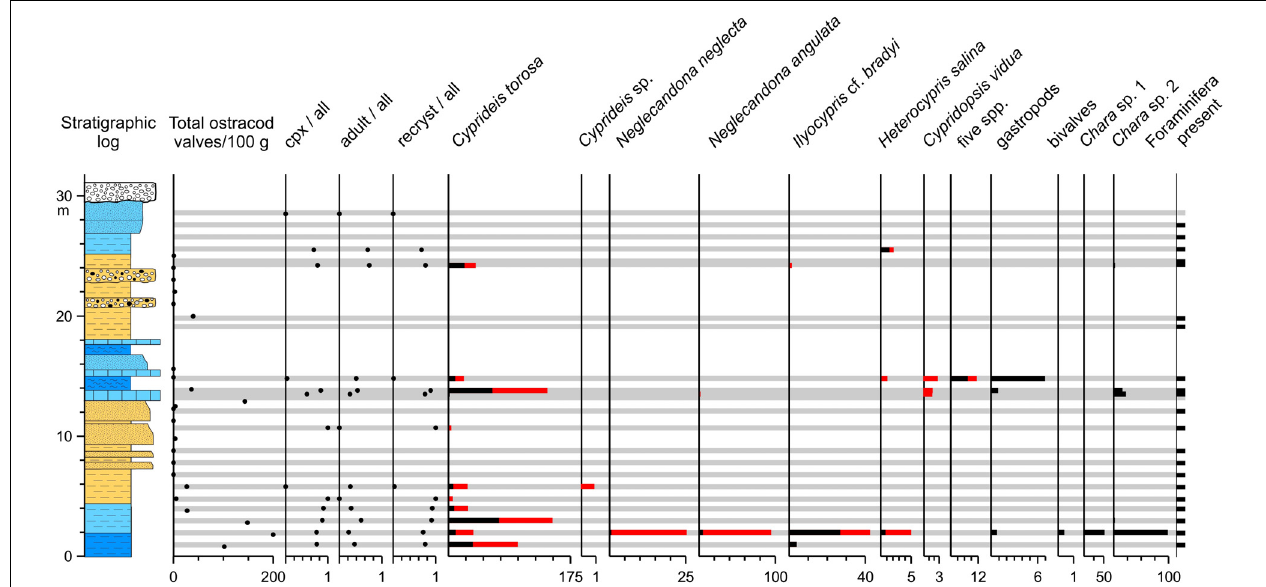
FIGURE 5 | Depth variations of relevant fossil remains from the Kuntila Lake sediments. The pooled five spp. are valves and larger fragments of the ostracods Potamocypris sp., Vestalenula cylindrica , Paralimnocythere sp., Cypris sp., and Herpetocypris sp. The gastropods are shells of Gyraulus sp., Lymnaeidae, ?Melanopsis and ?Valvata . Gray horizontal bars indicate the positions of